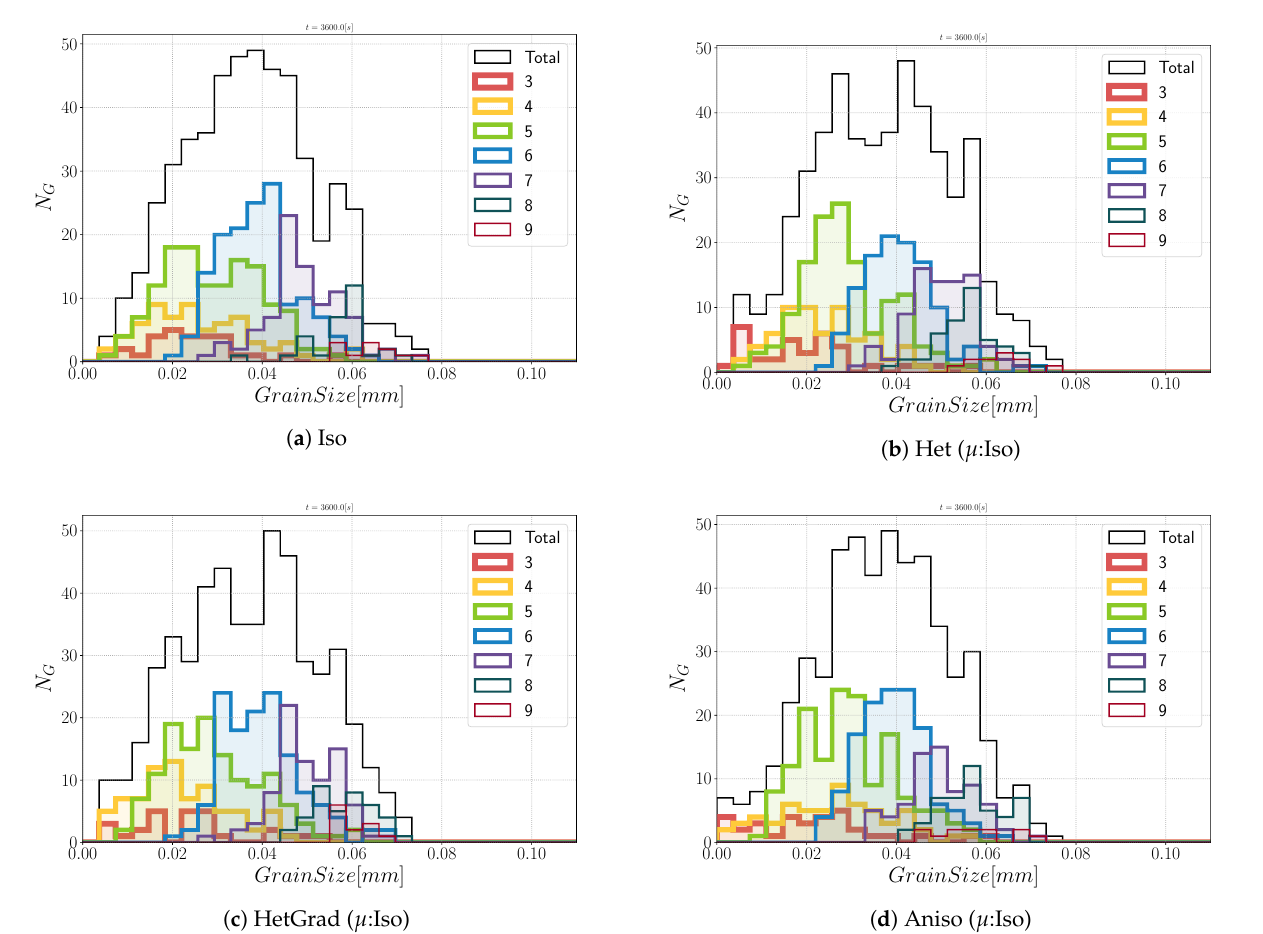
Figure 16. Grain size distribution and contributions from every group of grains of the same coordination number from 3 to 9 at t = 1